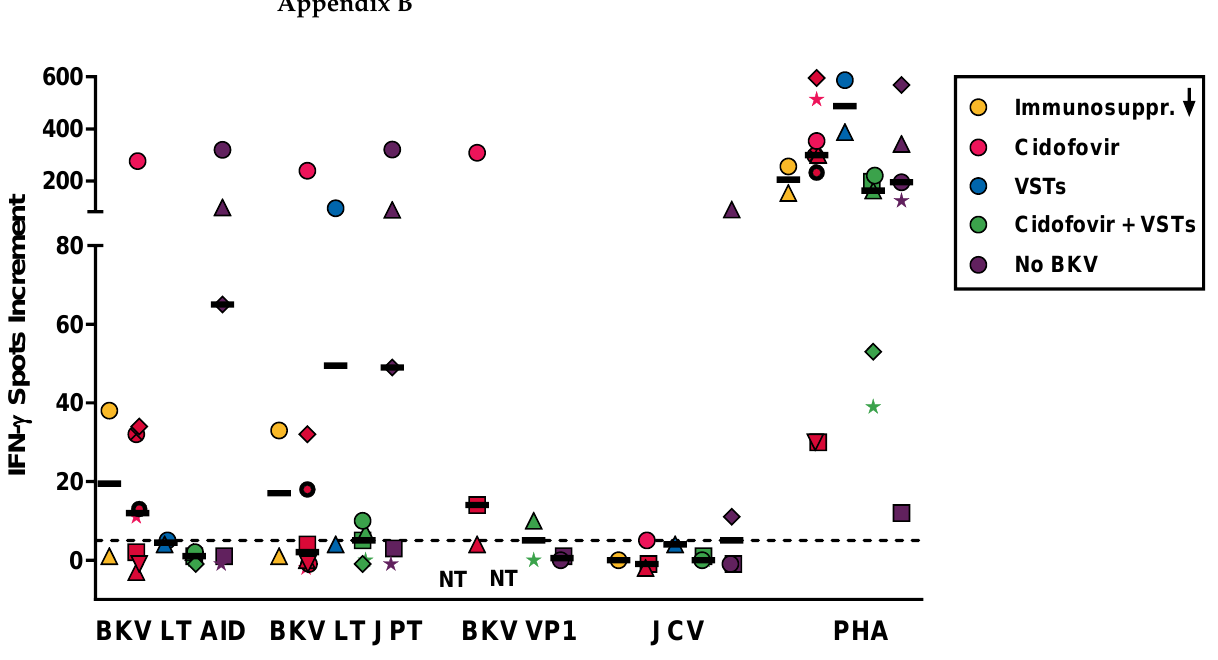
Figure A2. Cellular responses towards BK virus (BKV) large T (LT) peptides (from AID or JPT), as well as towards BKV viral protein 1 (VP1) and JC virus (JCV) peptides. Cell cultures stimulated with phytohemagglutinin (PHA) served as a positive control. The graph shows data on the first timepoint in hematopoietic stem cell transplant recipients with BKV infection, in whom only immunosuppres- sion was reduced ( n = 2), who was treated by cidofovir ( n = 8), who received virus-specific T cells (VSTs) ( n = 2), and who received cidofovir plus VSTs ( n = 5). For comparison, we present the results of transplant recipients who suffered from cystitis that was not related to BKV (control group, n = 5). Each patient is depicted by an individual symbol. The values correspond to the first timepoint, as shown in Figure 1, which is a median of 28 days after the onset of cystitis. Data are indicated as spots increment, i.e., BKV-specific spots minus negative control. Solid horizontal lines indicate median values. The dotted horizontal line indicates the cut-off for positive responses (five spots increment). NT, not tested. BKV LT AID—BKV large T peptides (from AID), BKV LT JPT—BKV large T peptides (from JPT), BKV VP1—BKV viral protein 1 peptides.